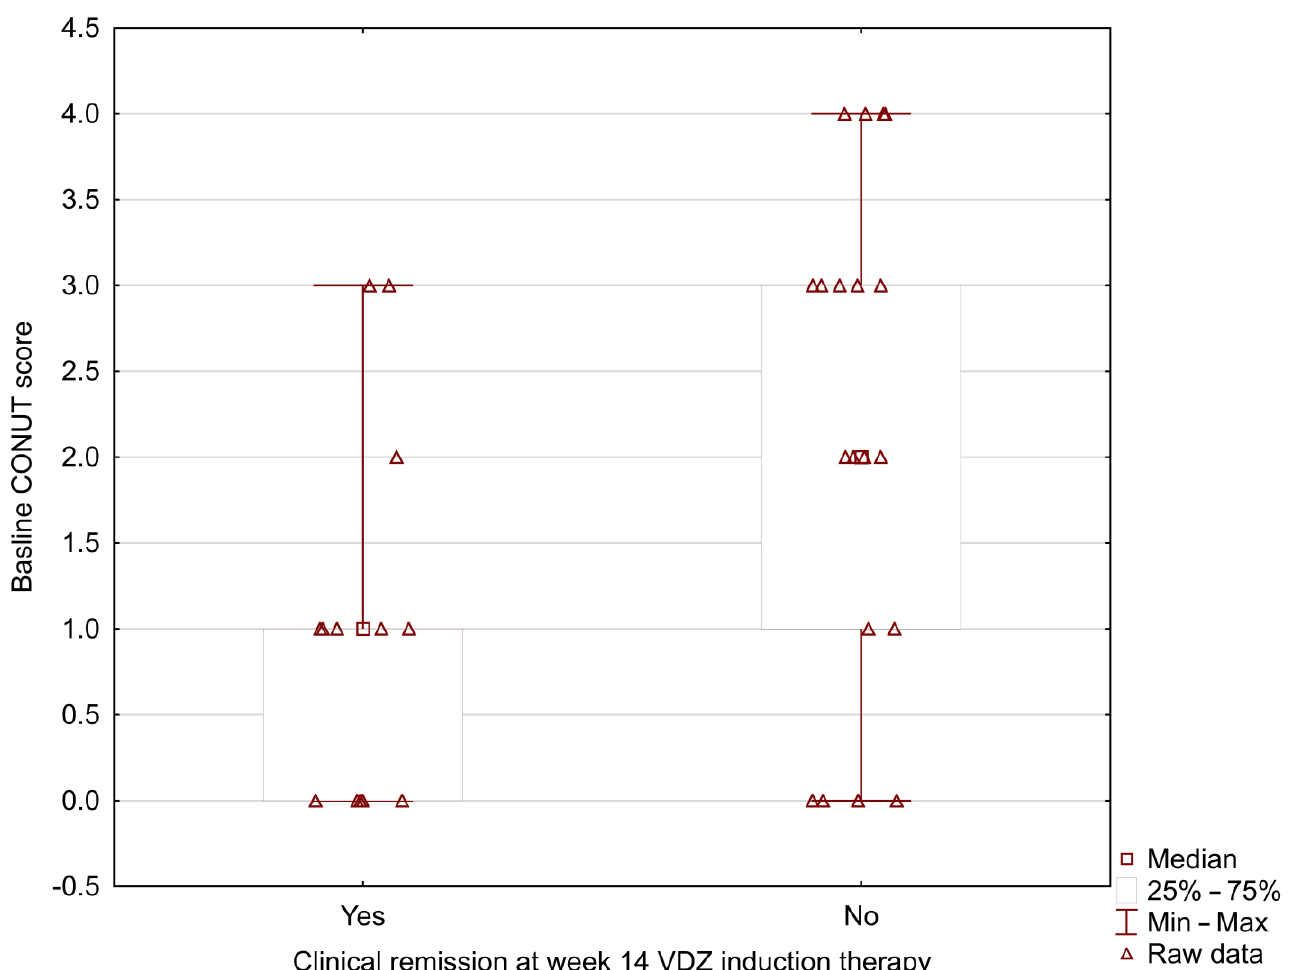
Figure 3. Relationship between the baseline CONUT score and clinical remission at week 14 during vedolizumab induction therapy (CONUT: 1.00 ± 1.08 vs. 2.16 ± 1.46; p = 0.031).